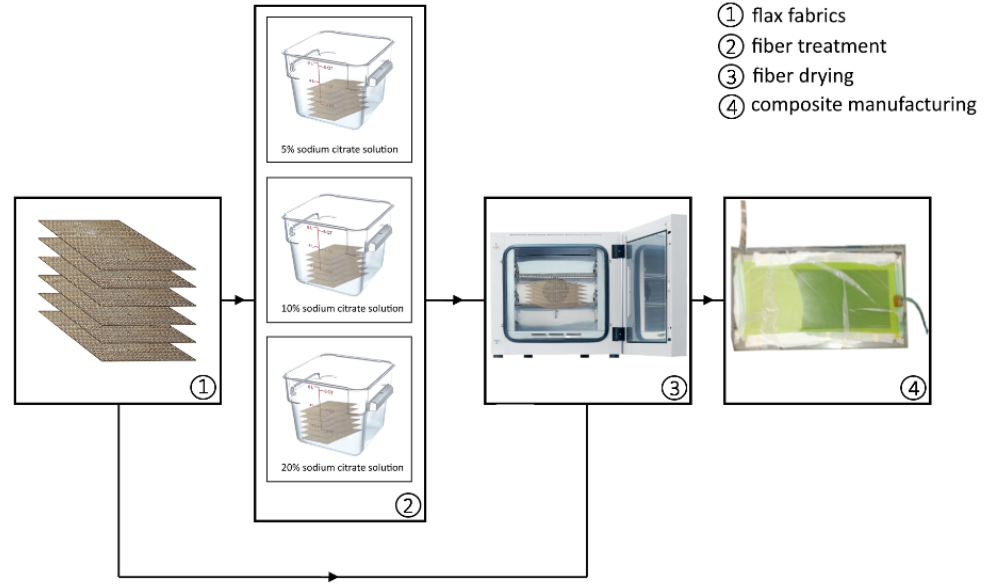
Figure 1. Flow diagram of the experimental procedure.